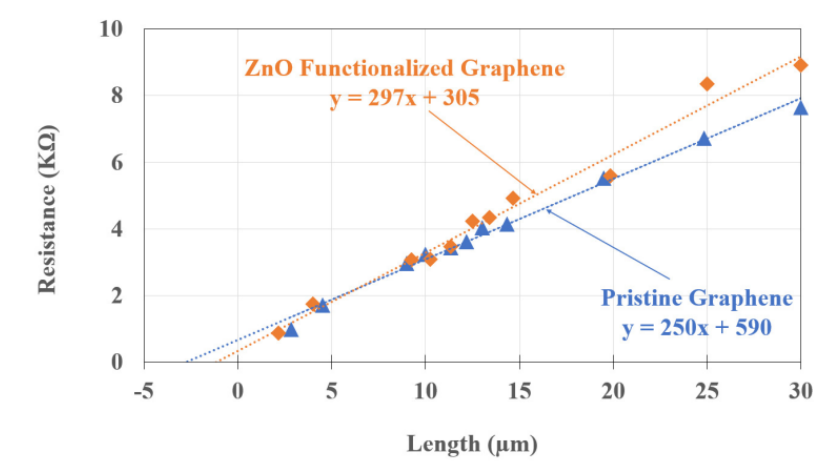
Figure 3. Resistance of pristine and ZnO functionalized graphene as a function of distance between metal contacts as measured after fabrication. The dotted lines are the transfer length method (TLM) linear fits.